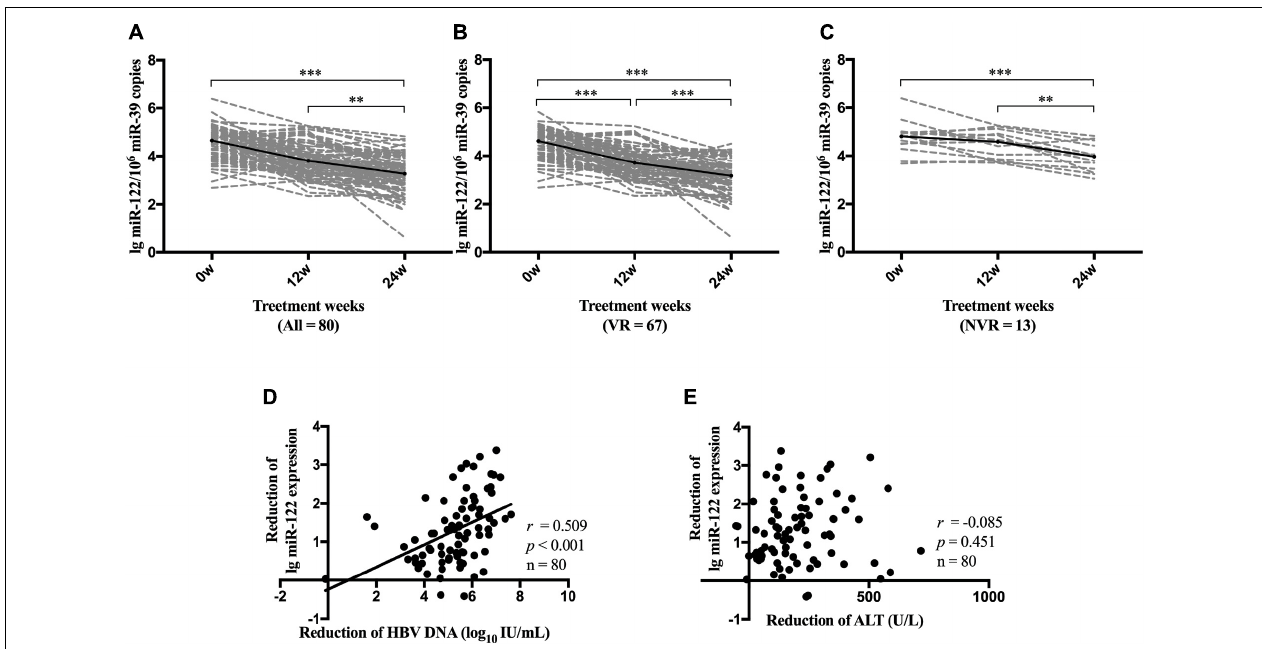
FIGURE 4 | Dynamic change of miR-122 level during NA therapy. Dynamic change of miR-122 levels among all patients (A) , VR group (B) and NVR (C) group were evaluated. Spearman’s correlations between reduction of serum miR-122 levels and the reduction of viral load (D) or the reduction of ALT levels (E) were conducted at week 24. VR, virological response; NVR, non-virological response. ∗∗ p < 0.01; ∗∗∗ p < 0.001.